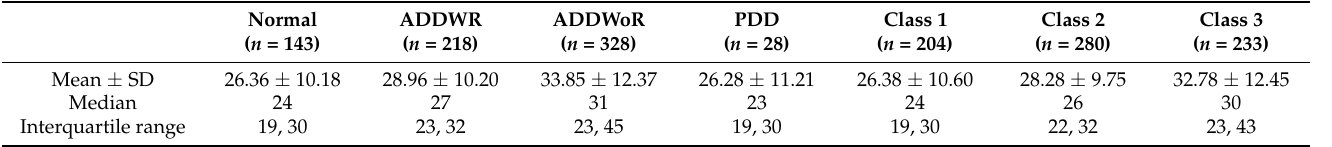
Table 2. Age data of study